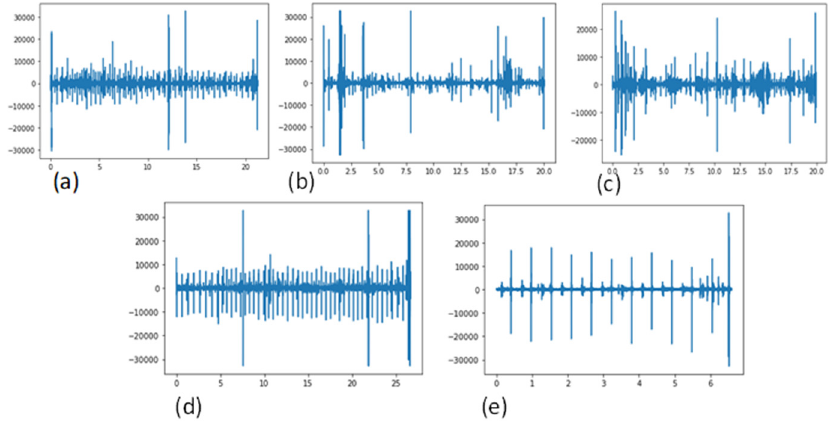
Figure 1. Signals of the existing CVD classes, using a phonogram, ( a ) Aortic stenosis (AS), ( b ) Mitral regurgitation (MR), ( c ) Mitral stenosis (MS), ( d ) Mitral valve prolapse (MVP) and ( e ) Normal.